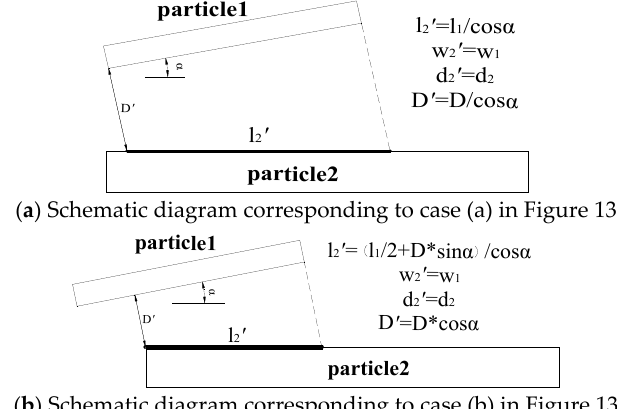
( b ) Schematic diagram corresponding to case (b) in Figure 13 Figure 14. Schematic diagram of the projection step treating plate1 as the wall. Figure 14. Schematic diagram of the projection step treating plate1 as the